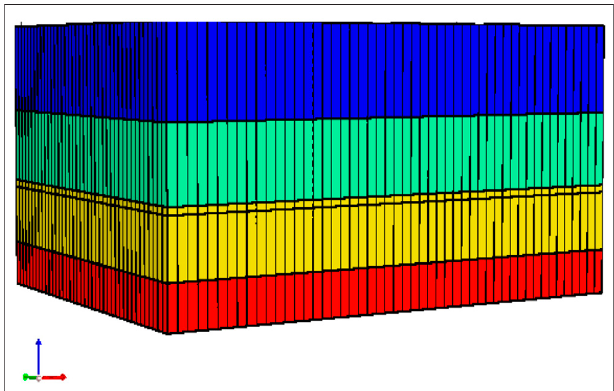
FIGURE 1 | Reservoir model used in this study.